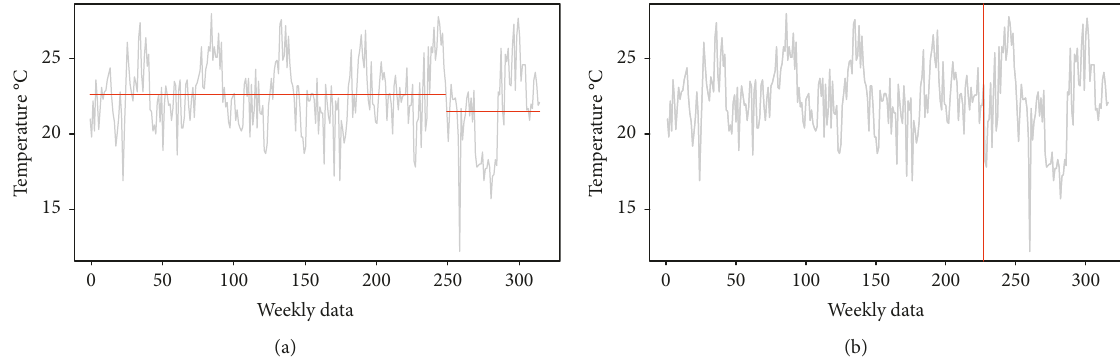
Figure 6: Location of change points for the (a) mean and (b)